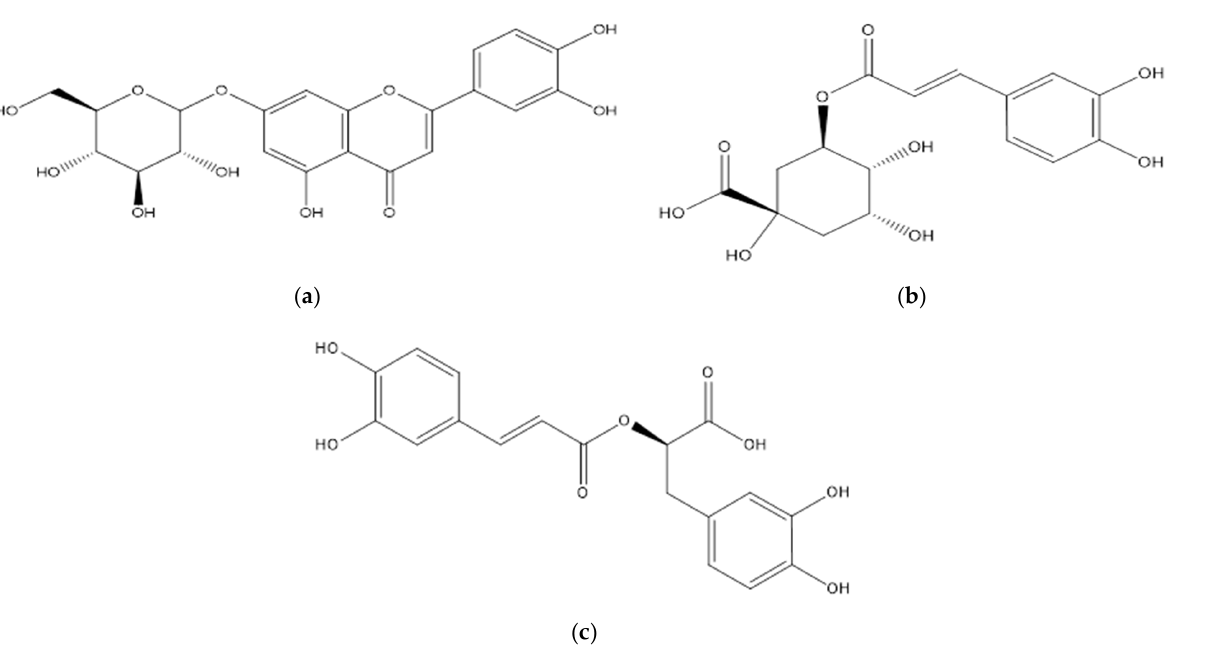
Figure 5. Structure of BASs from T. vulgare extracts: ( a ) luteolin ‐ 7 ‐ glucoside; ( b ) chlorogenic acid; ( c ) rosmarinic acid.